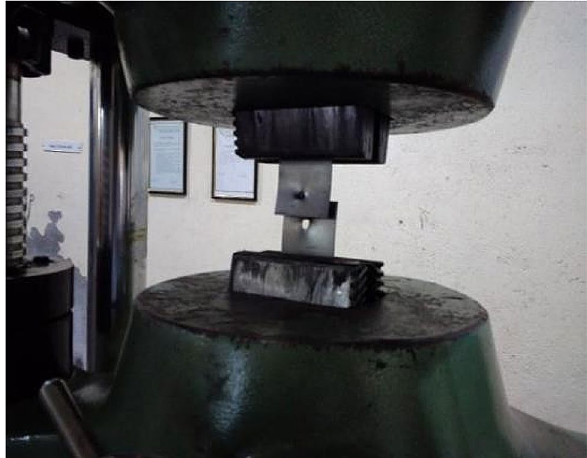
Fig. 4 Breaking load determination in Universal Testing